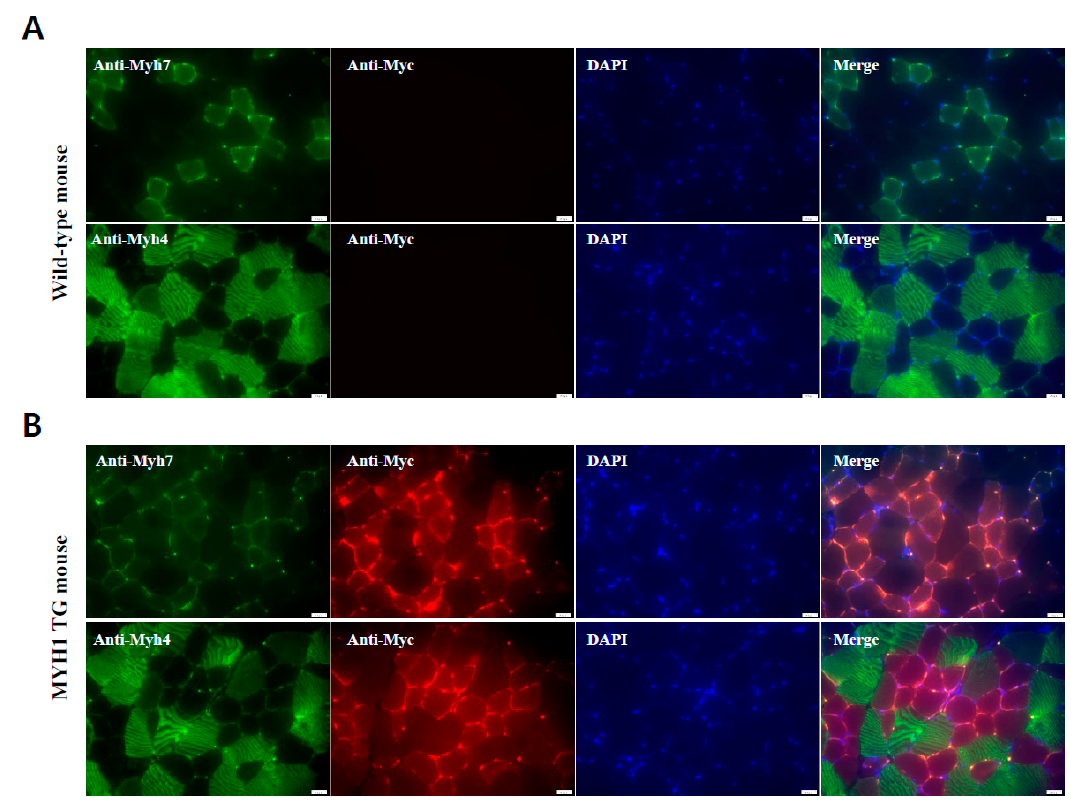
Figure 3. Localization of ectopic overexpressed Myh1 gene between slow and fast muscle fibers. Analysis of Immunohistochemistry in quadriceps muscles of ( A ) WT and ( B ) Myh1 TG mice. Anti-MYH7 and anti-MYH4 were detected by green fluorescence, whereas anti-Myc was detected by red fluorescence. 4’,6-diamidino-2-phenylindole (DAPI)-stained nuclei. The scale bar represents 20 µm.